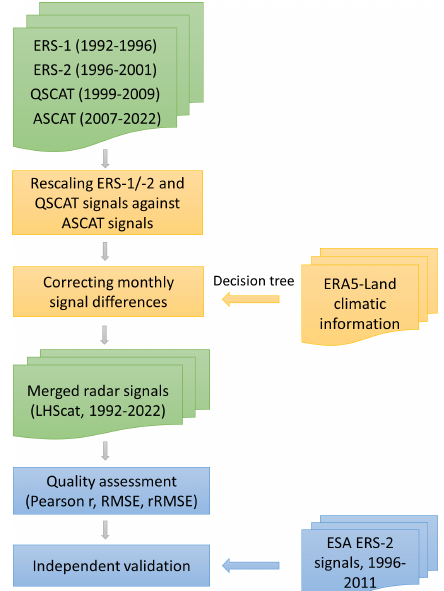
Figure 2. Flow chart illustrating the development and assessment of the LHScat data set. Inputs/outputs are coloured in green, the signal-merging procedures coloured in yellow, and assessment and validation for the merged signals coloured in